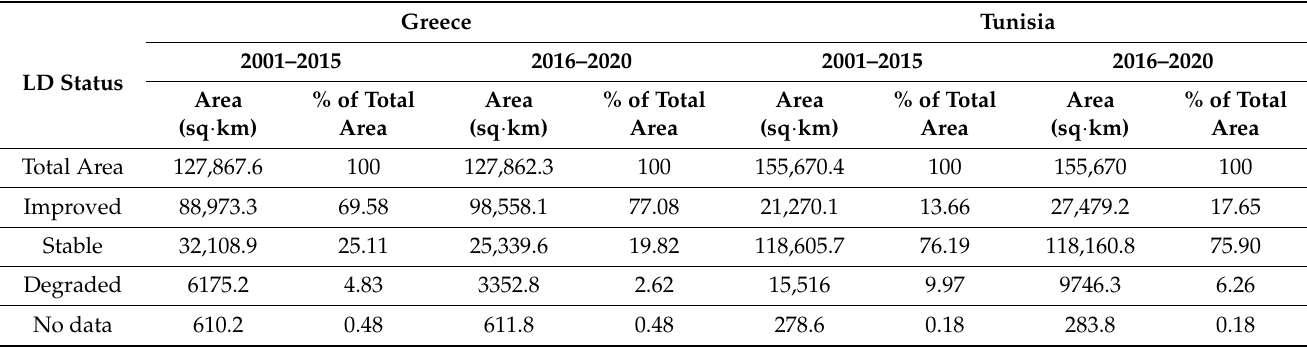
Table 1. Land degradation metrics for the baseline and reporting periods in Greece and